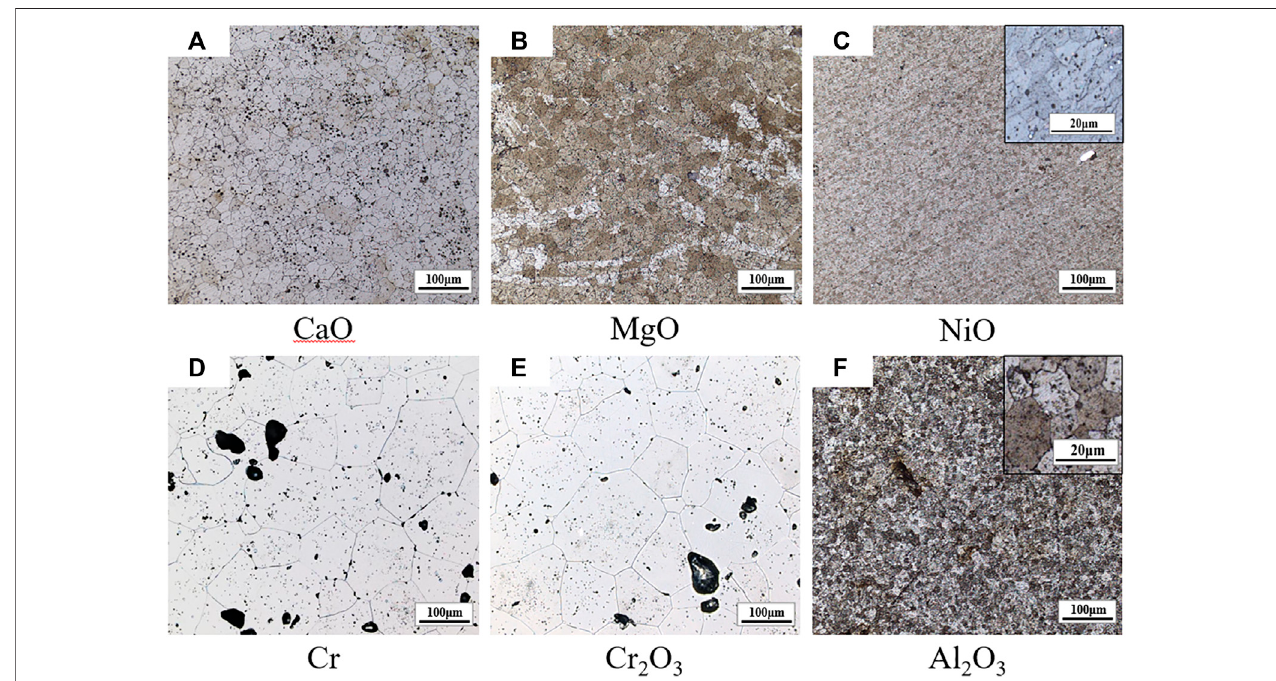
FIGURE 1 | Grain morphologies of UO 2 doped with different additives. The types of these additives are marked below the diagram.